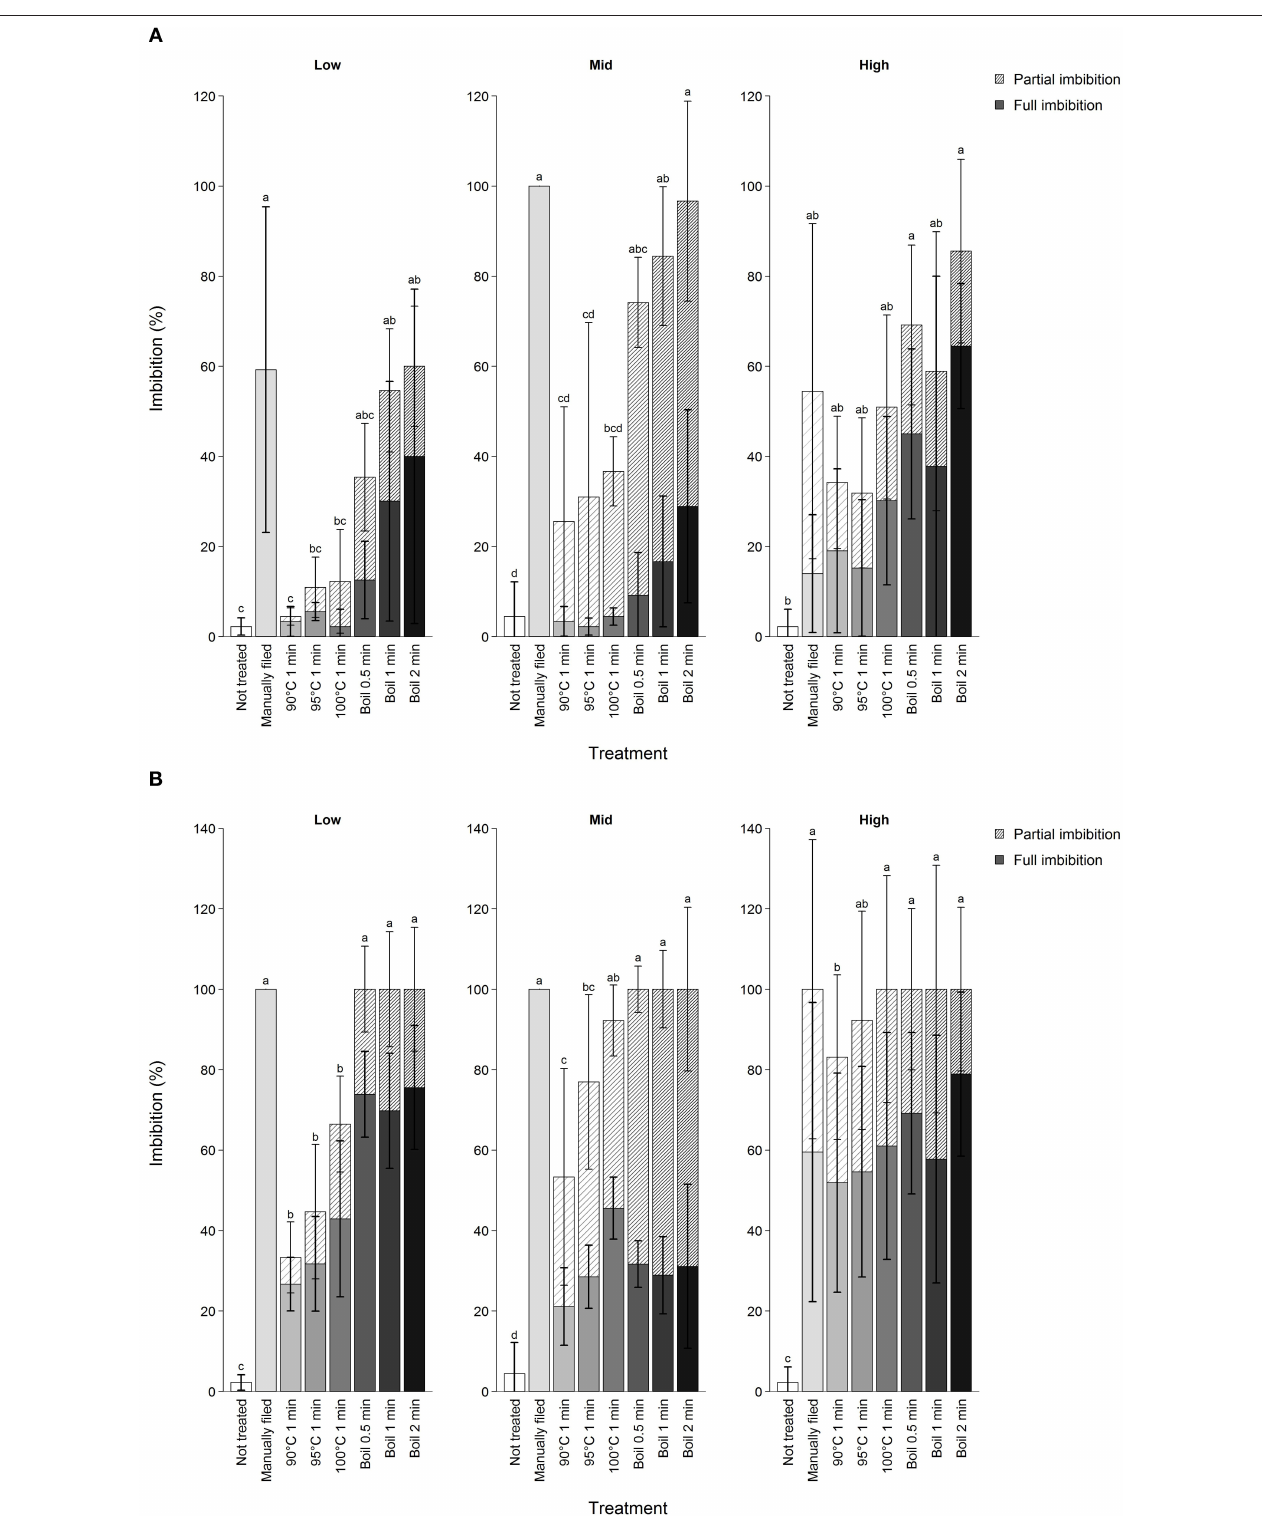
FIGURE 2 | Imbibition percentage of koa seeds by different scarification treatment after (A) first treatment attempt and (B) first through up to 15 attempts combined excluding those that were subjected to manual filing afterwards. Scarification treatments are ordered from the least intense to the most intense from left to right, indicated by the darkness of the bar color. Hatched and filled bars show partial and full imbibition, respectively. Error bars are standard deviation shown separately for full (bold) and partial imbibition for seeds from three trees per elevation range. Different letters indicate difference in total imbibition percentage among treatments for each elevation range at α =